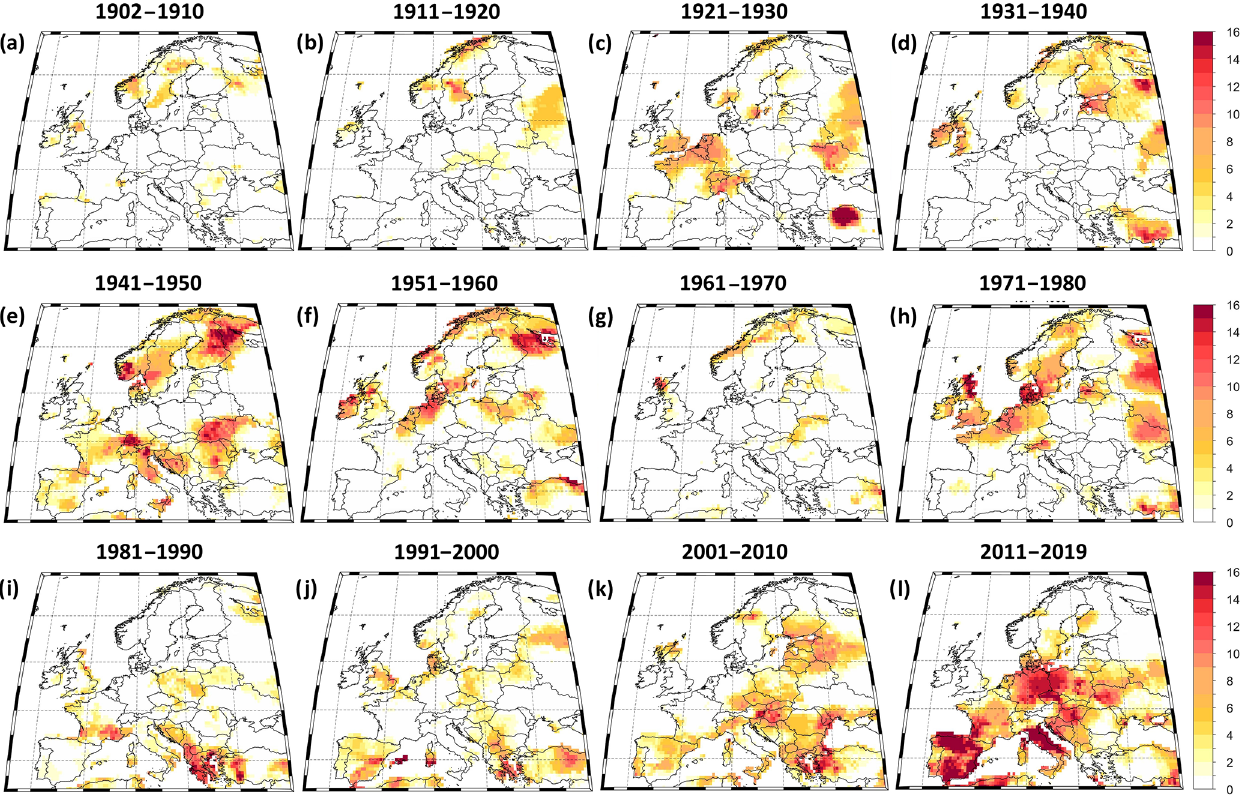
Figure 7. Decadal frequency of drought duration for extreme drought (SPEI12 < − 2). (a) 1902–1901, (b) 1911–1920, (c) 1921–1930, 2019. Units: number of months per